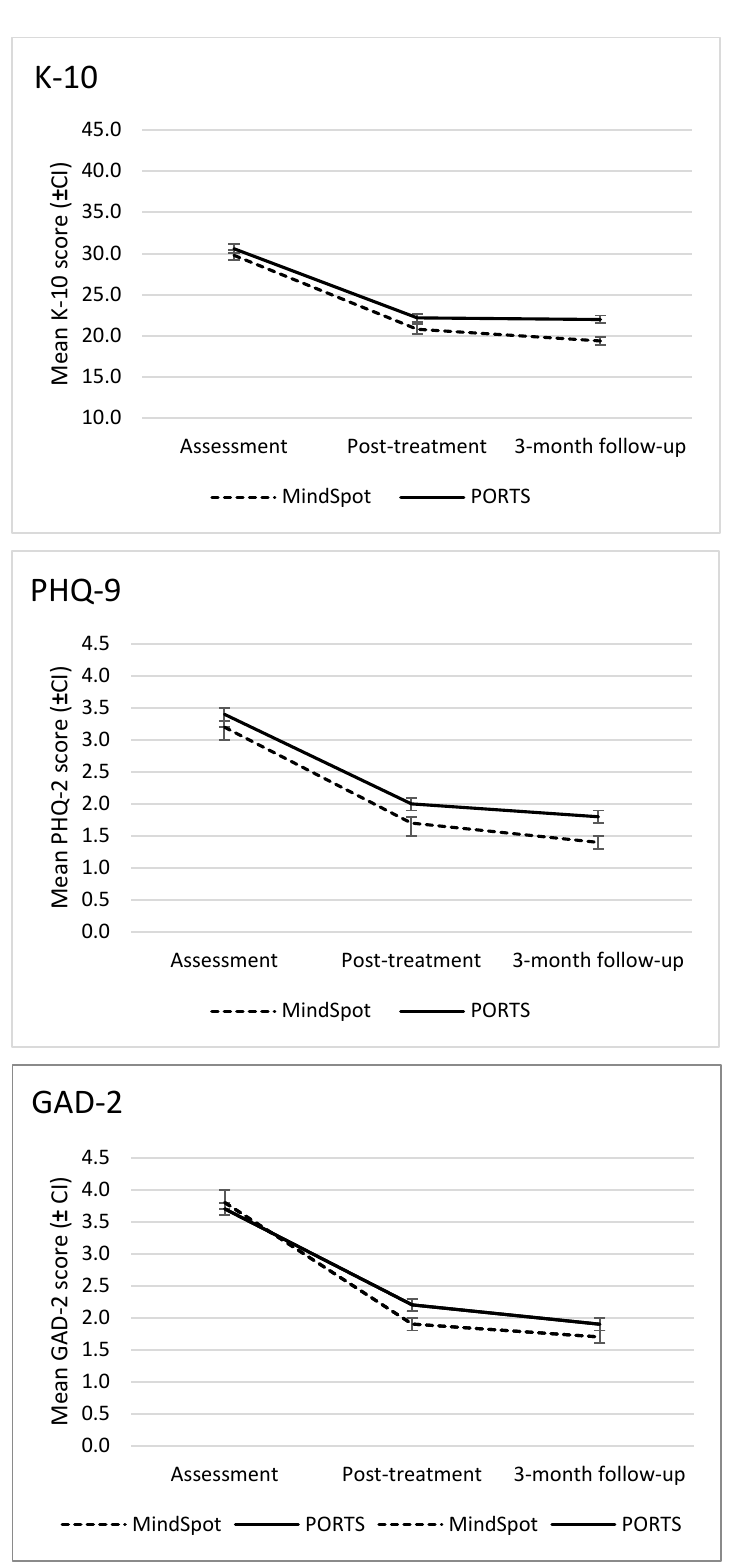
Figure 2. Comparison of symptom reductions for PORTS and MindSpot, from assessment to post- treatment and 3-month follow-up. Error bars represent 95% confidence intervals. Means and standard deviations for each time point are shown in Table 2.